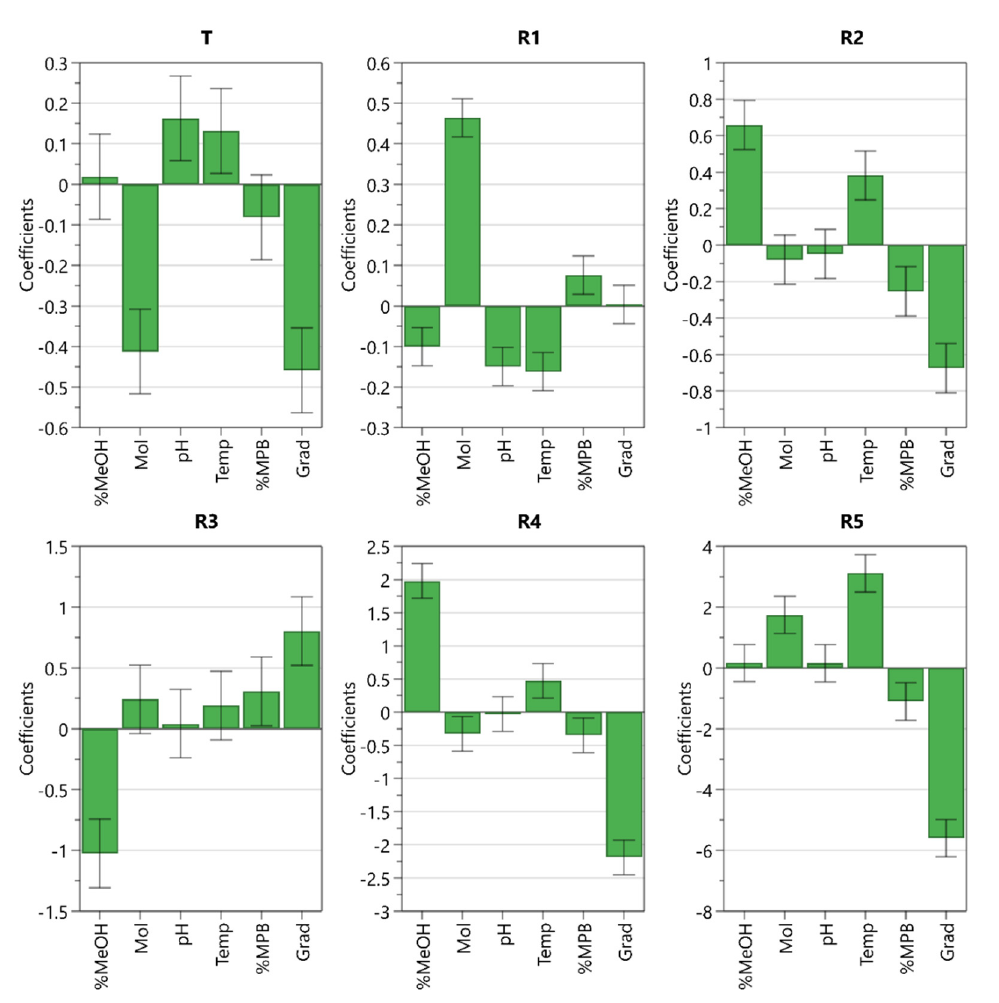
Figure 3. Coefficient plot for models created using fractional factorial (resolution IV) screening design including coefficients and confidence intervals.